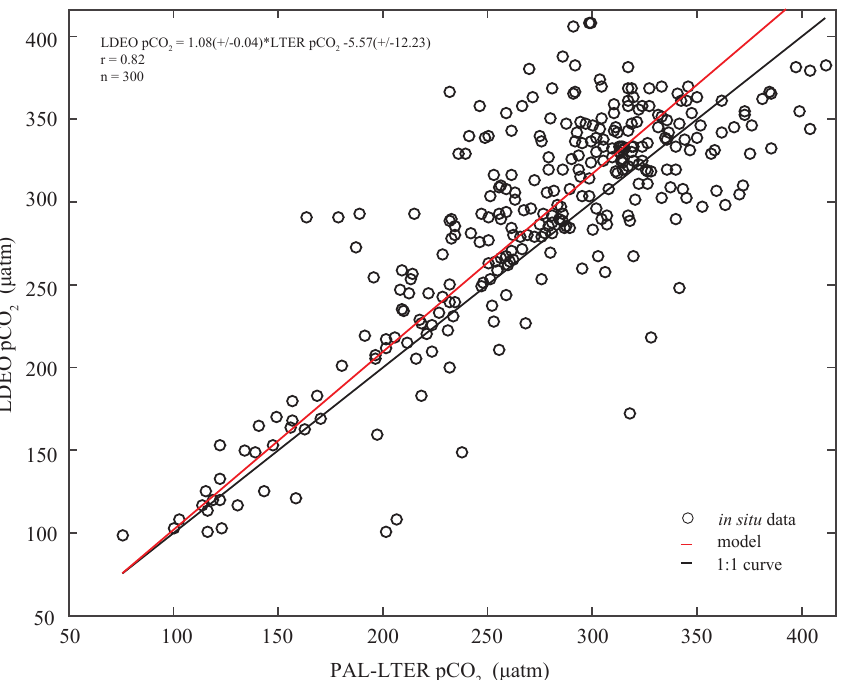
Figure A1. Comparison of Lamont-Doherty Earth Observatory of Columbia University (LDEO) continuous underway p CO 2 (µatm) over the Palmer-Long Term Ecological Research (PAL-LTER) sampling grid (Takahashi et al., 2015) with p CO 2 (µatm) derived from PAL-LTER dissolved inorganic carbon (DIC, µmolkg − 1 ) and total alkalinity (TA, µmolkg − 1 ) from discrete samples taken during the same cruise (2005– 2012). PAL-LTER p CO 2 outliers that underestimate/overestimate p CO 2 relative to the underway observations by more than 150µatm were removed. The two data sets were spatially matched, with a 1km distance threshold. See Table 1 for